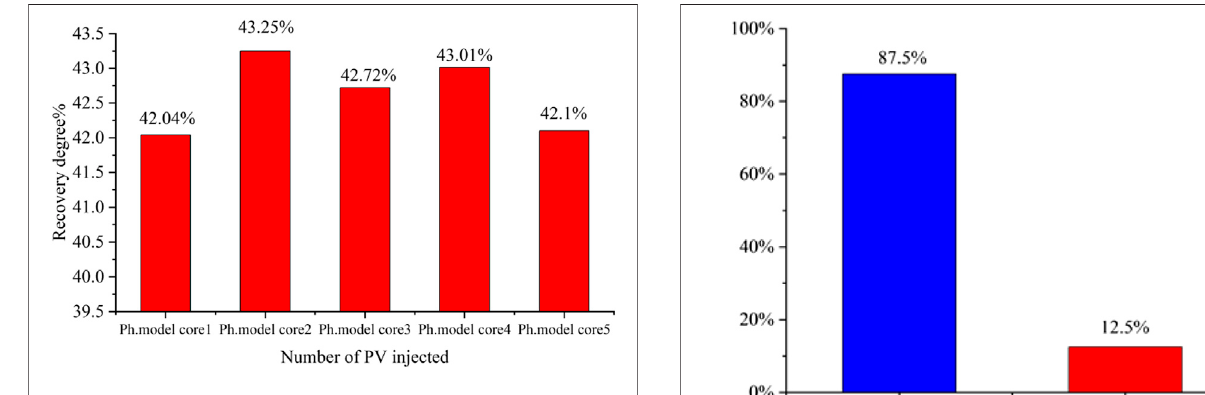
FIGURE 11 | Histogram of the comparison of the degree of digital and analog extraction.